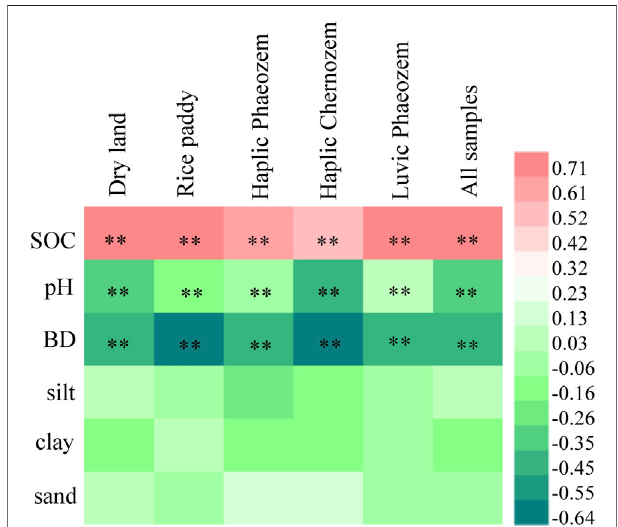
FIGURE 1 | Relationship of soil total nitrogen density (STND) and soil properties in 0 – 100 cm depth was analysed using Pearson correlations; ** represent signi fi cance at the 0.01 probability level.